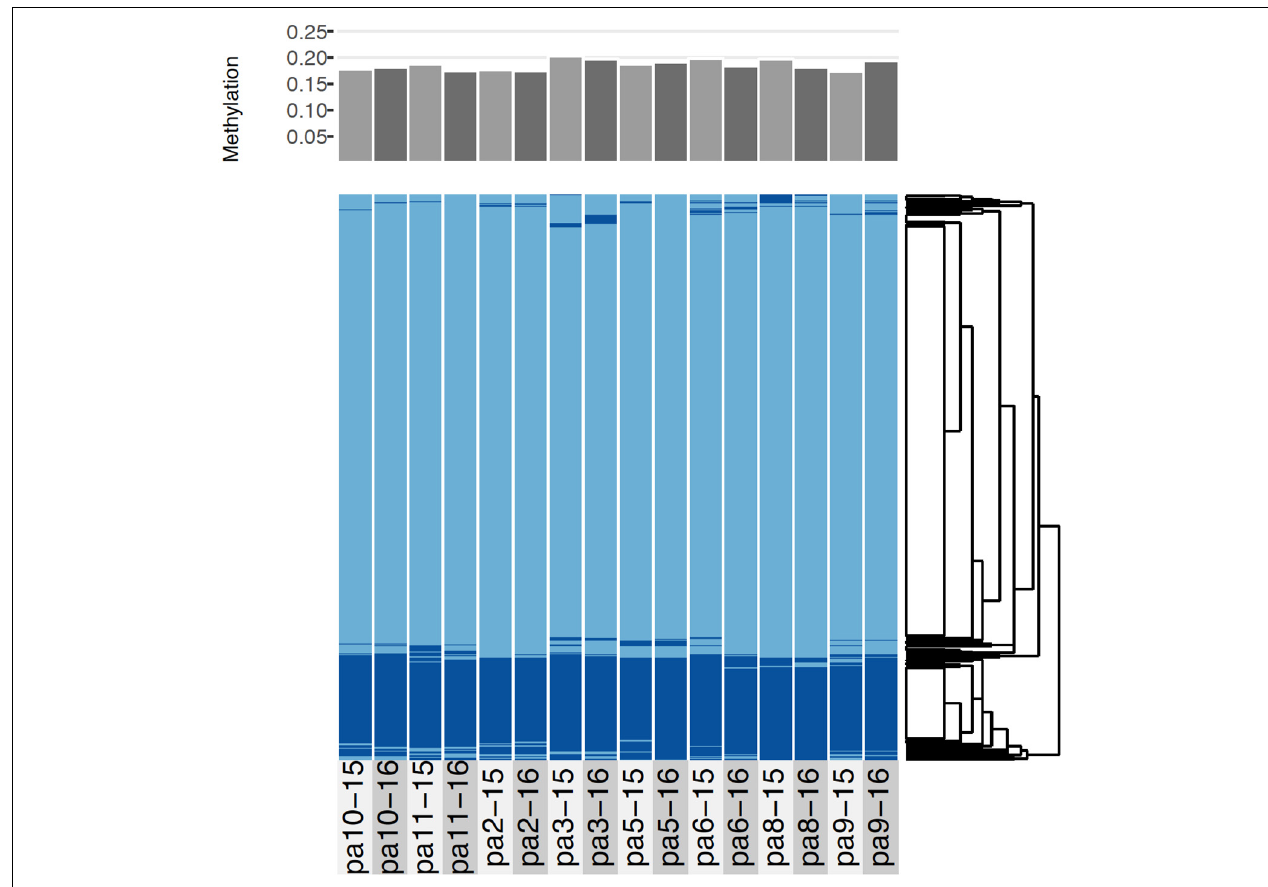
FIGURE 4 | Comparative methylation profiles of the eight P. astreoides samples from 2015 to 2016. Every two vertical bars is a single individual, with the first bar showing 2015 methylation and the second showing 2016 methylation. Top panel shows proportion of methylated loci, while bottom panel shows a heatmap with methylated loci in dark blue and unmethylated loci in light blue, ordered via hierarchical